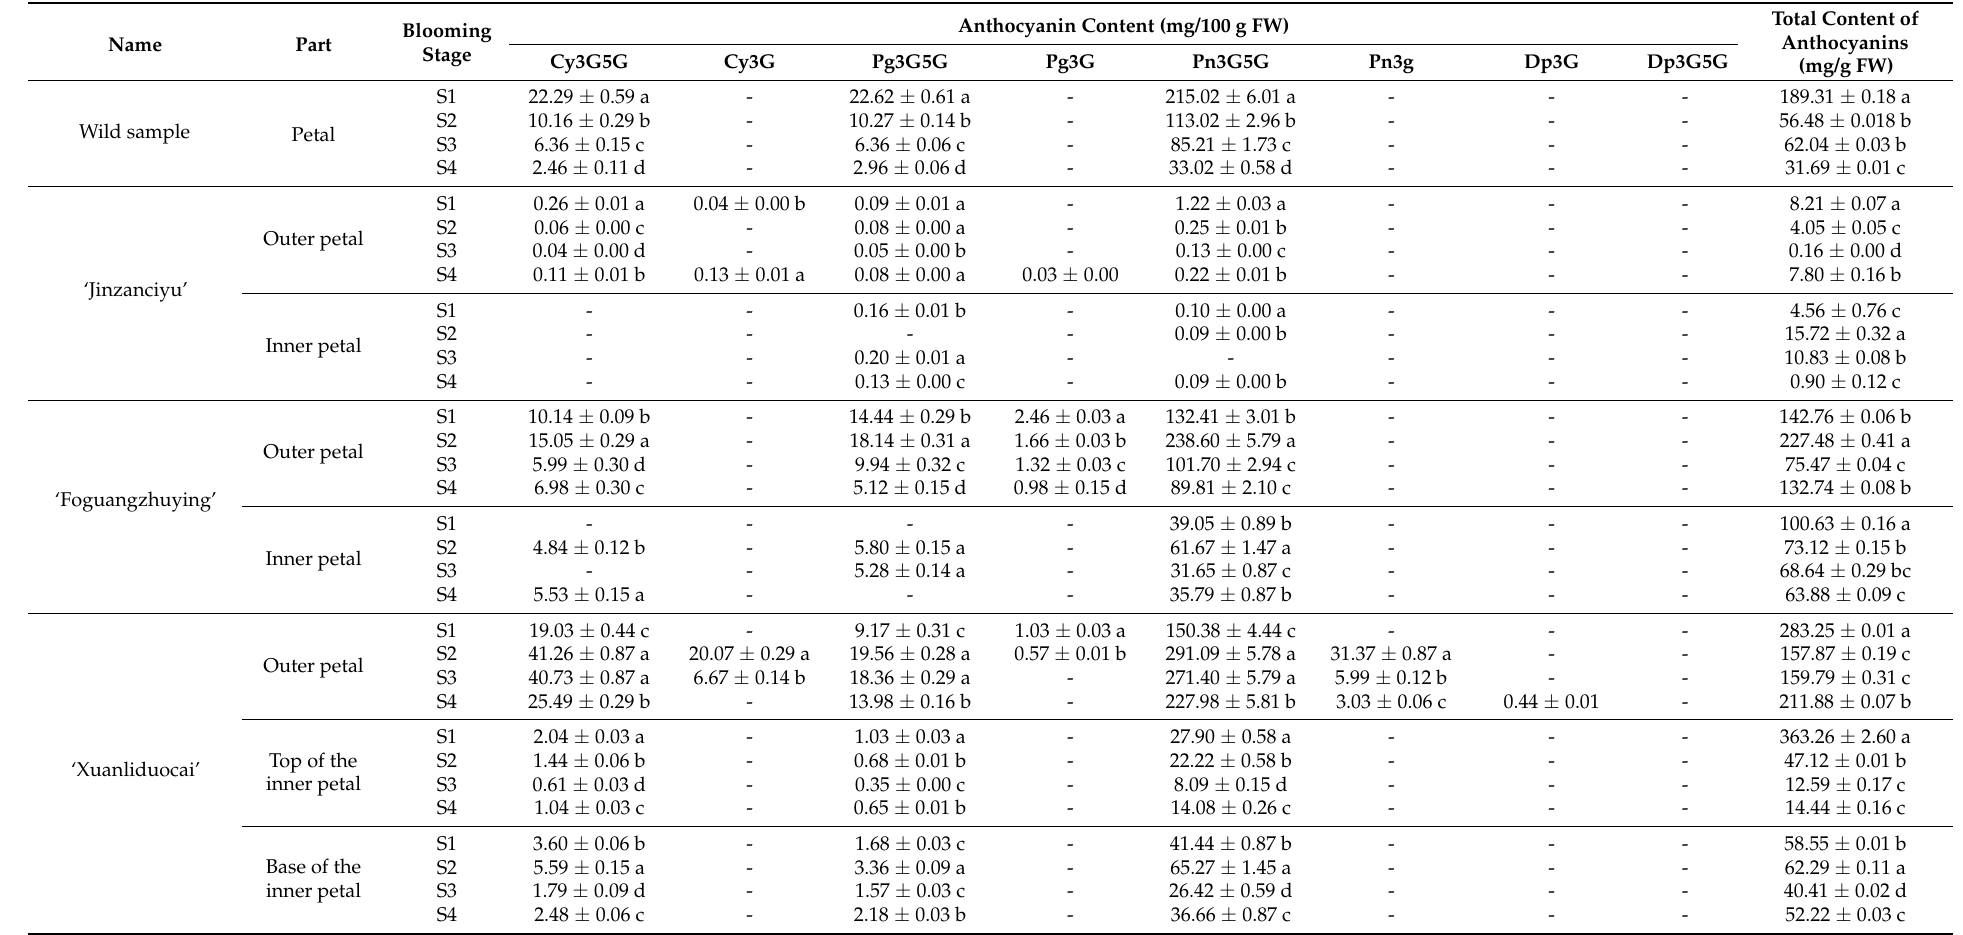
Table 1. Composition and content of anthocyanins in herbaceous peony